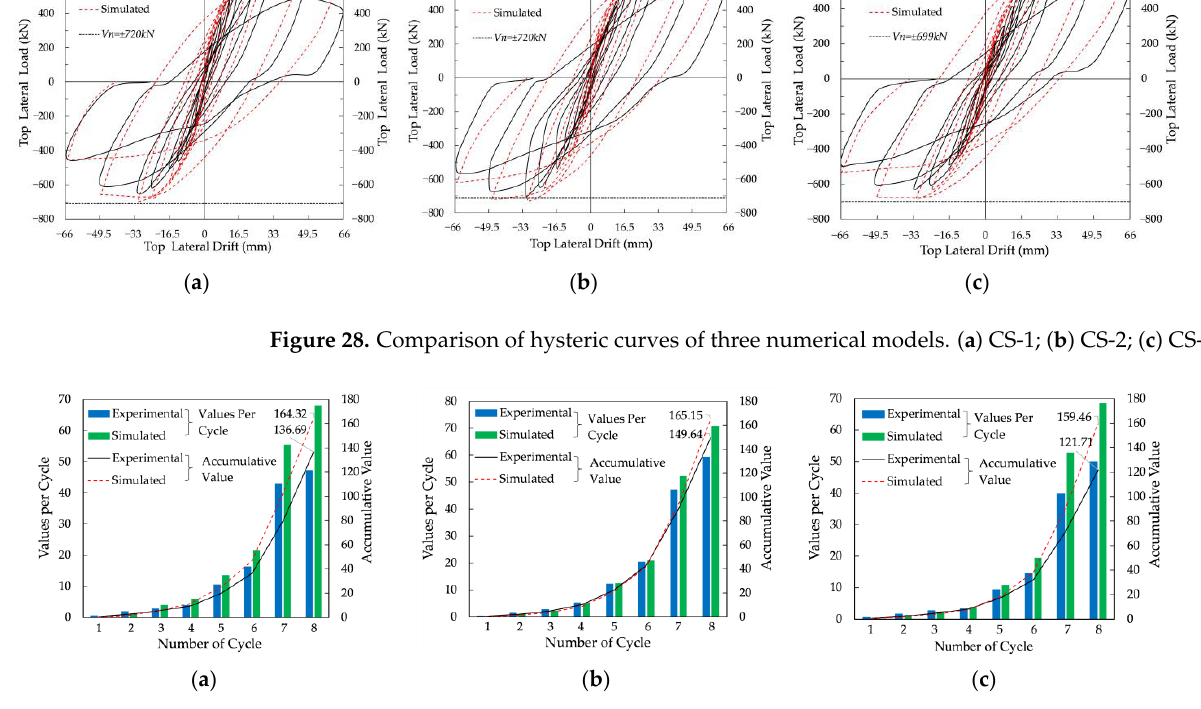
Figure 28. Comparison of hysteric curves of three numerical models. ( a ) CS-1; ( b ) CS-2; ( c ) CS-3.